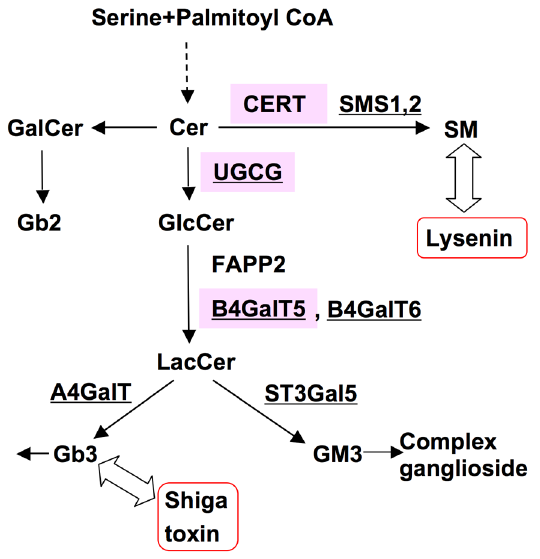
Figure 1. Sphingolipid biosynthesis in mammalian cells and sphingolipid binding toxins. The biosynthetic pathway of sphin- golipids relevant to this study is shown. Underlining indicates enzymes for sphingolipid biosynthesis. Pink-shaded boxes indicate the products of genes that were targeted by TALENs in this study. Red-lined boxes indicate the toxins used in this study. Cer, ceramide; SM, sphingomyelin; GlcCer, glucosylceramide; LacCer, lactosylceramide; Gb3, globotriaosyl- ceramide; GalCer, galactosylceramide; Gb2, galabiosylceramide (Gal a 1- 4GalCer); SMS, sphingomyelin synthase; UGCG; UDP-glucose: ceramide glucosyltransferase, B4GalT5, b -1,4-galactosyltransferase 5; B4GalT6, b - 1,4-galactosyltransferase 6; FAPP2, four-phosphate adaptor protein 2.